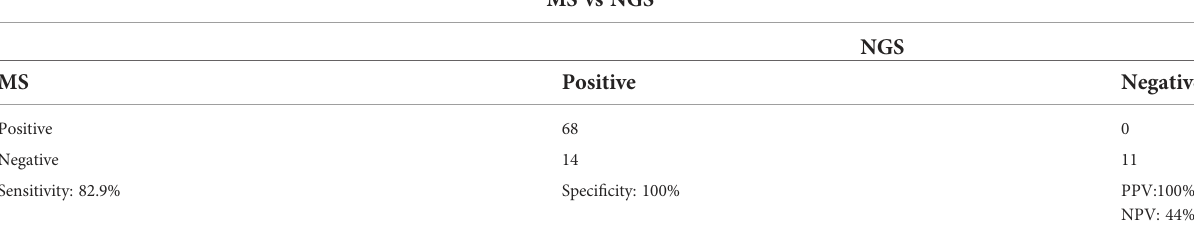
TABLE 3 Comparison of NGS and MS methods in detecting multiple gene mutations from FNA